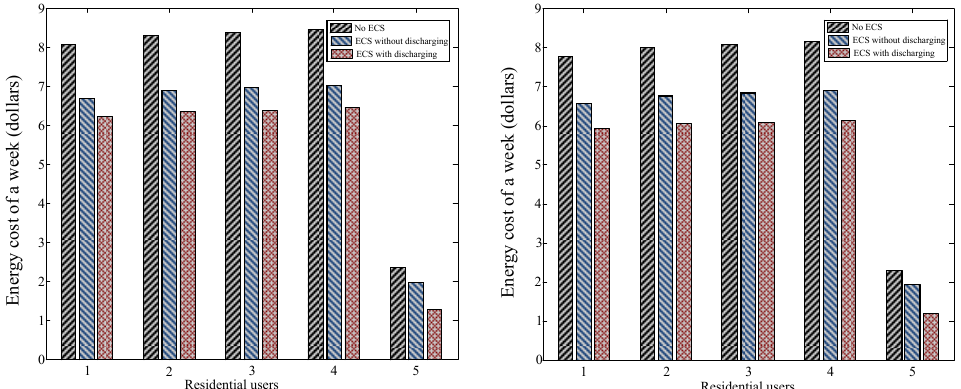
Figure 5. The total cost of a week for all residential users: without the game among utility companies on the left and with the game among utility companies on the